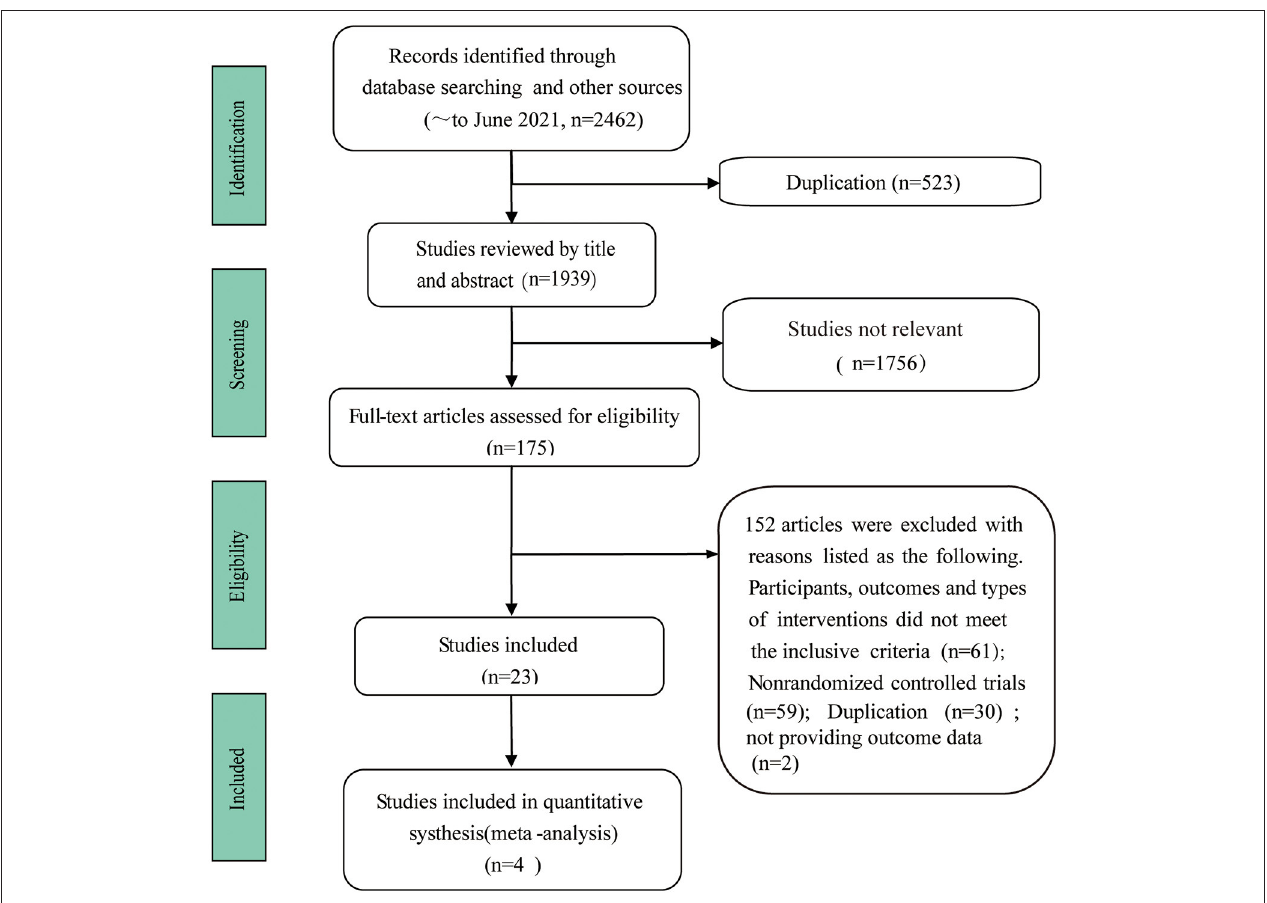
FIGURE 1 | Flow diagram of study selection